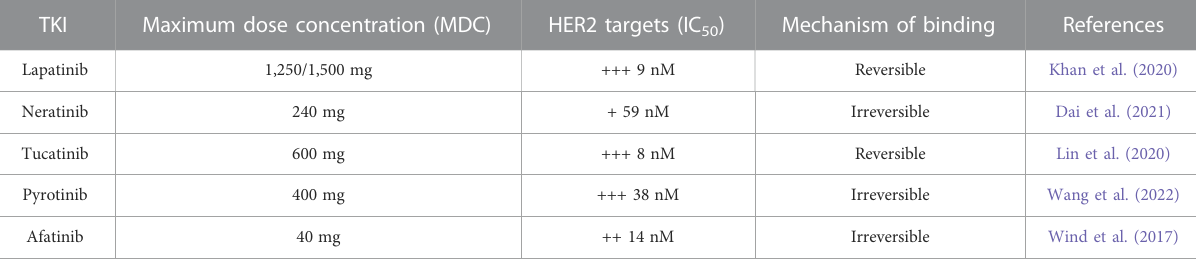
TABLE 3 TKIs are used in the treatment of HER2+ metastatic breast cancer. TKI